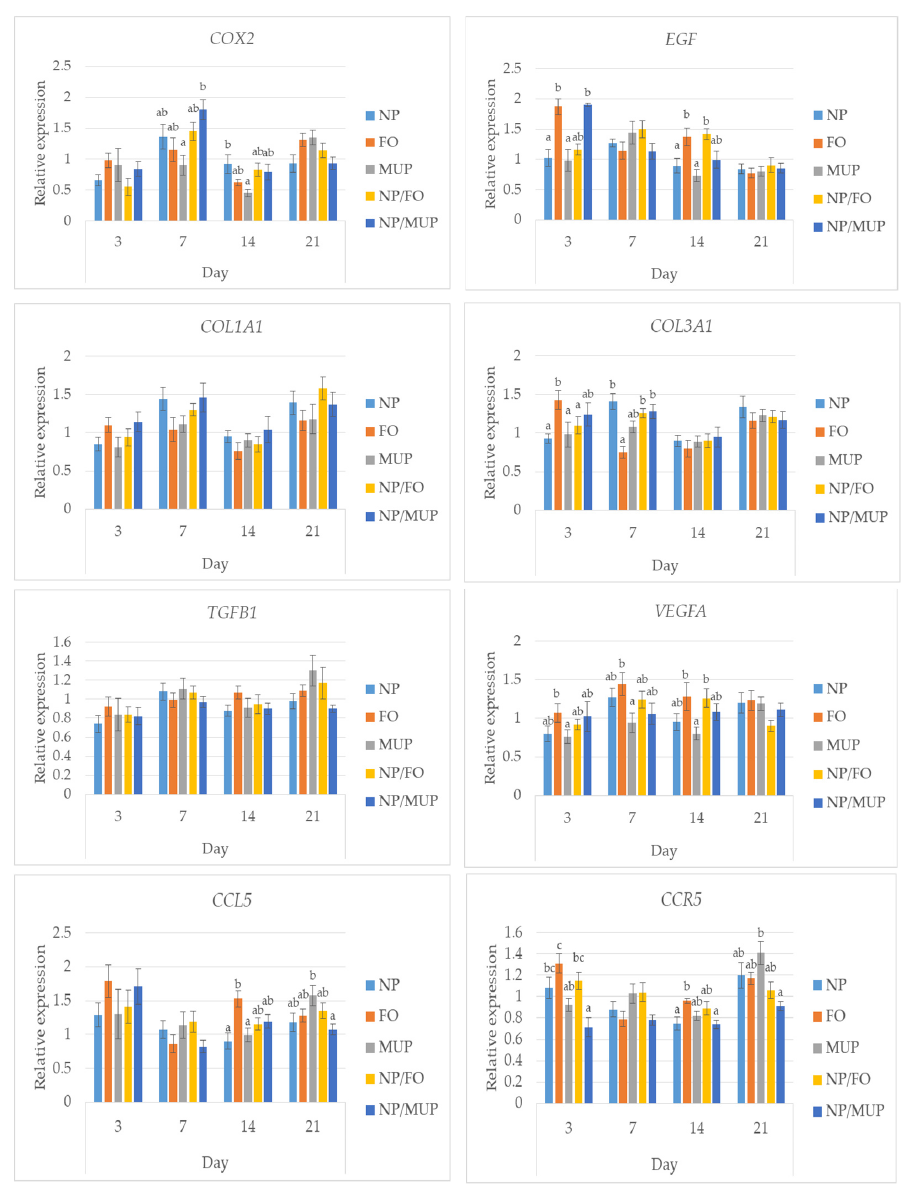
Figure 5. Relative expressions of the genes relevant to inflammation (prostaglandin-endoperoxide synthase 2, COX2 ), cell growth and differentiation (epidermal growth factor, EGF ), collagen for- mation (alpha-1 type I collagen, COL1A1 ; alpha-1 type III collagen, COL3A1 ), cell proliferation and wound healing (transforming growth factor beta-1, TGFB1 ), angiogenesis (vascular endothelium growth factor alpha, VEGFA ), and chemotaxis and immune cells recruitment (chemokine-C-C motif ligand 5, CCL5 ; C-C chemokine receptor type 5, CCR5 ). NP—dressing with empty poly(lactic-co- glycolic) acid (PLGA)-polyvinyl alcohol (PVA) nanoparticles (NPs); FO—dressing with fish oil; MUP—dressing with mupirocin; NP/FO—dressing with PLGA-PVA NPs with entrapped fish oil; NP/MUP—dressing with PLGA-PVA NPs with entrapped mupirocin. Mean ± SEM. a–c: means with different superscripts within a given time interval differed significantly ( p < 0.05); One-way analysis of the variance ratio test with Tukey’s post hoc test . 2.4. Microbiological Analysis When summed over all treatments, the total microbial counts (TMCs) increased ( p < 0.05) from 0 log CFU/25 cm 2 (day 0; samples were sterile immediately after excisions) to